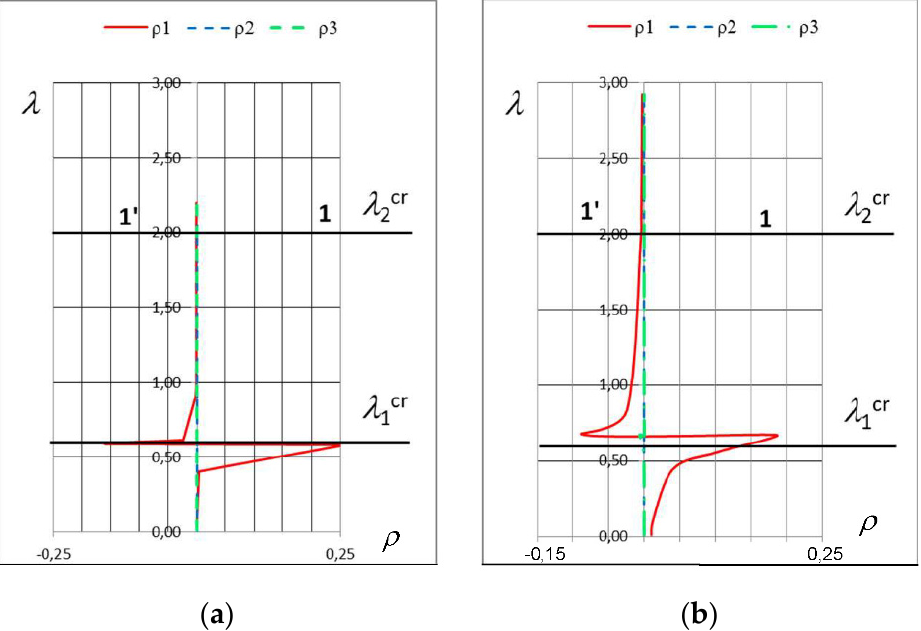
Figure 8. Coefficient ρ for geometrical imperfections developed according to the first buckling mode: ( a ) small ( m 1), ( b ) large ( d 1).